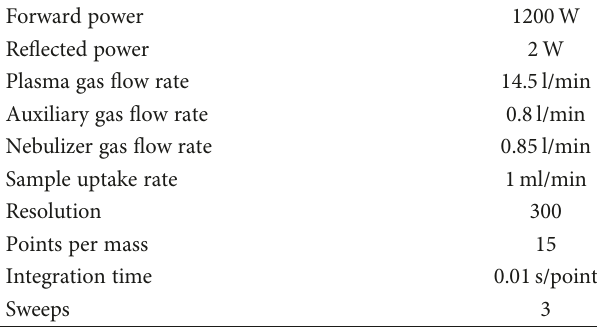
Table 1: Parameters of the